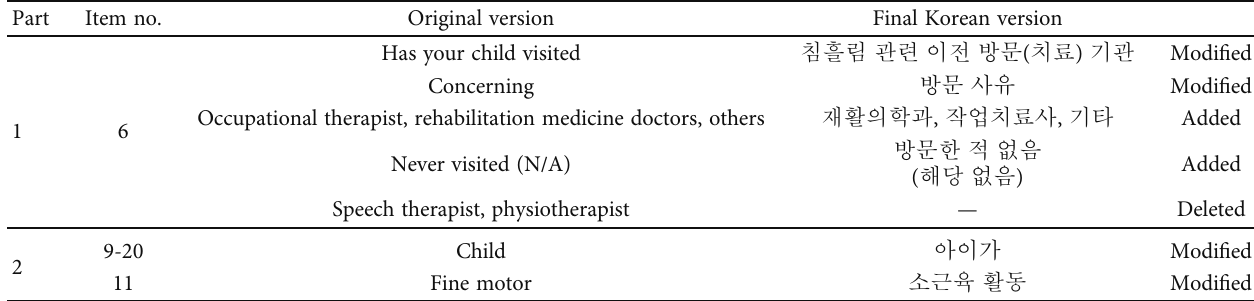
Table 1: Examples of the fi nal translation of the Drooling Infants and Preschoolers Scale (DRIPS) from English to Korean. Part Item